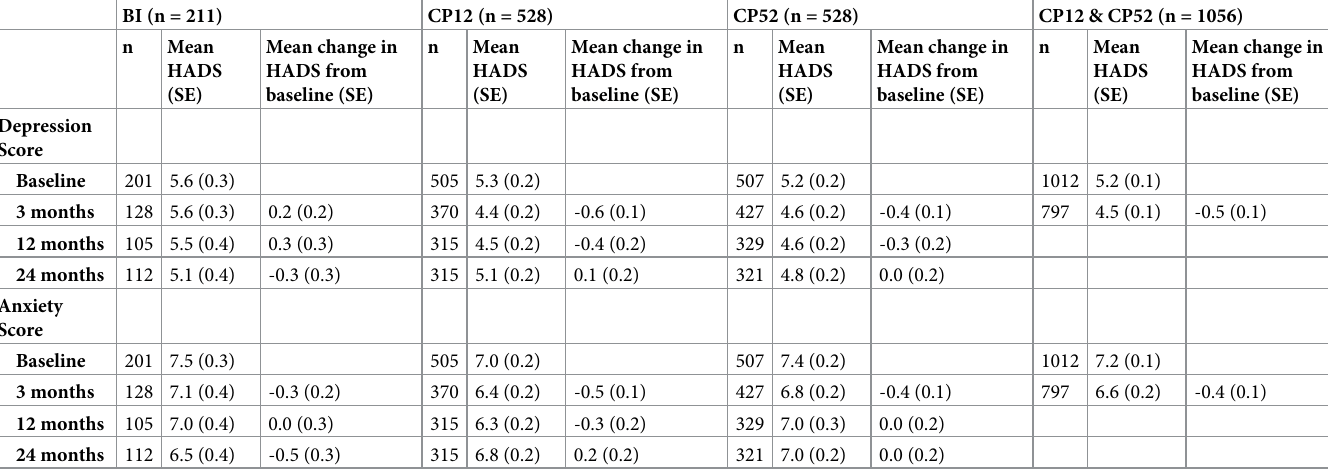
Table 2. Change in anxiety and depression score from baseline by allocated programme. BI: Brief intervention. CP12: 12-week commercial provider weight loss pro- gramme. CP52: 52-week commercial provider weight loss